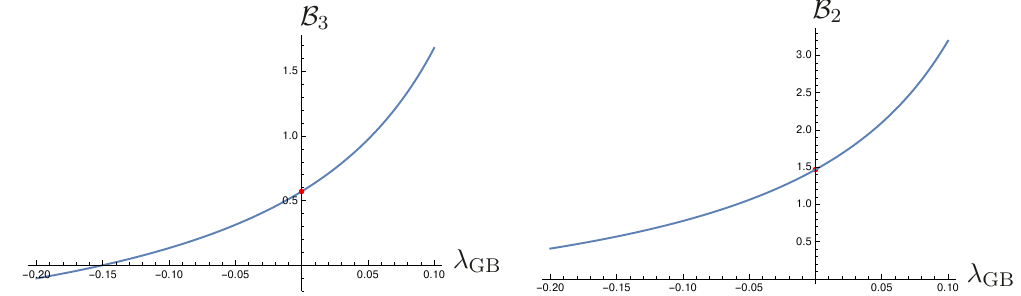
Figure 5 . Bulk viscosity of the holographic RG flows induced by dimension ∆ = 3 (left panel) and ∆ = 2 (right panel) operators, see (3.7). The red dots indicate the λ GB = 0 results obtained in [25, 26].